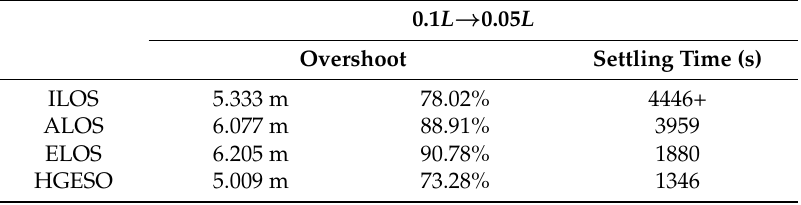
Figure 12. The desired heading angle vs. the true heading angle in the proposed guidance law at varying desired paths. Table 4. Comparison of overshoot and settling time at varying desired paths.